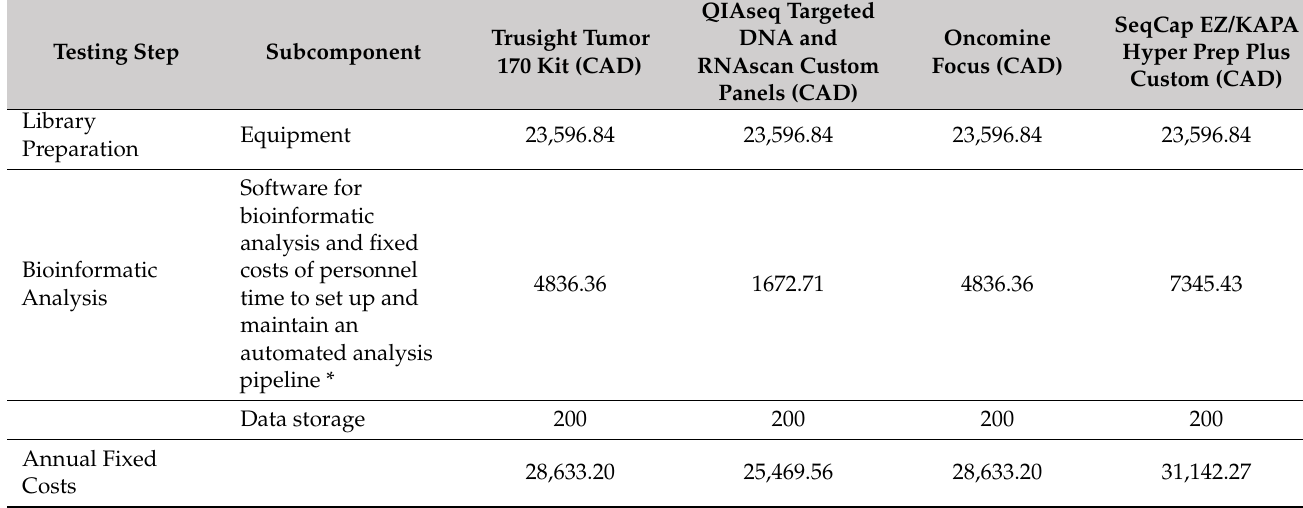
Table 2. Annual fixed costs of NGS, by assay.